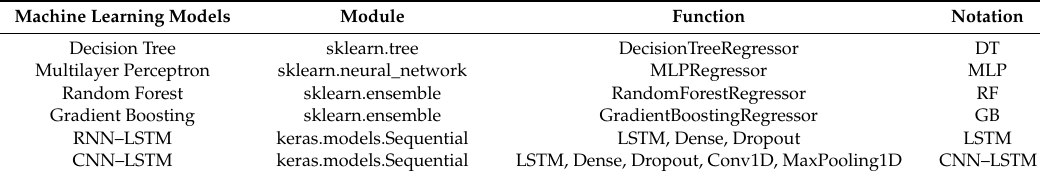
Table 2. The description of machine learning